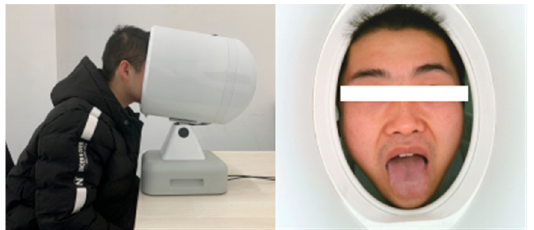
Figure 2. The process of capturing tongue images. During the collection, the subjects place their mandibles on the instrument and extended their tongues